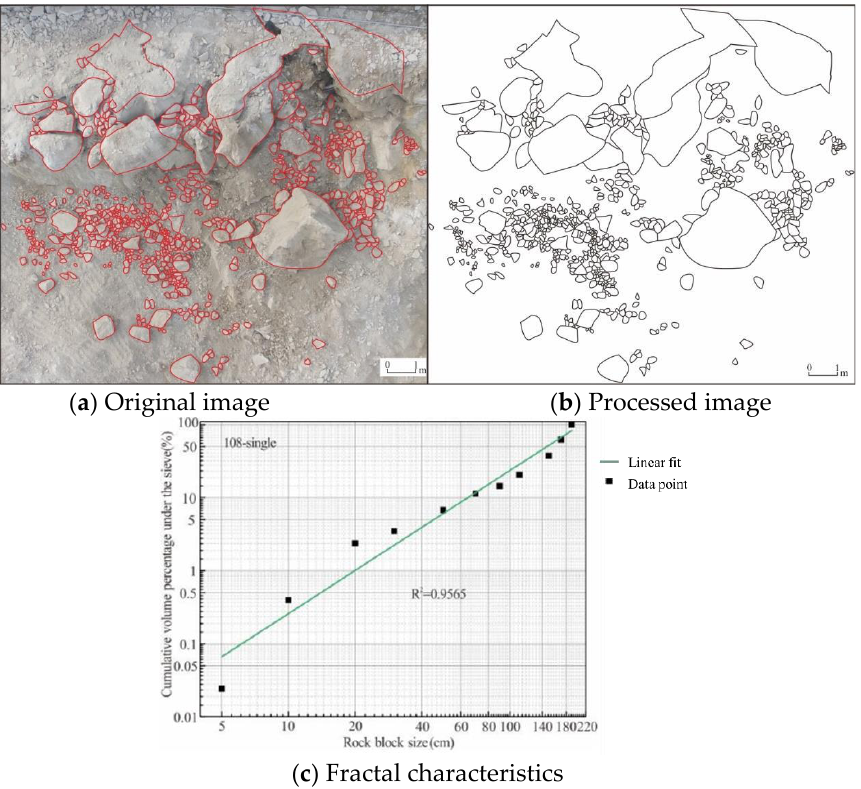
Figure 17. Distribution and fractal characteristics of CDPTB cracked blocks [41].